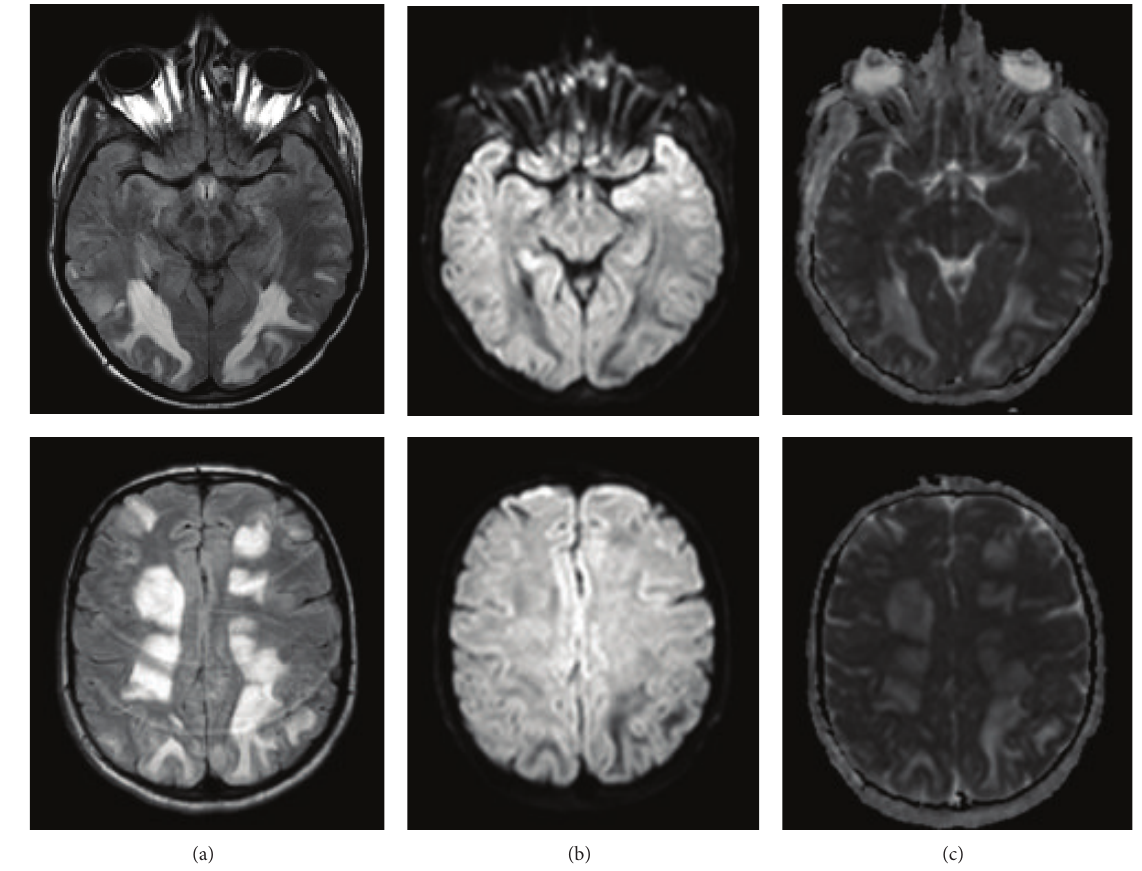
Figure 1: MRI manifestations of Patient 1. (a) Axial fluid attenuated inversion recovery (FLAIR) showed symmetrical high signal intensities in subcortical occipito-parietofrontal regions. ((b)-(c)) Diffusion-weighted magnetic resonance imaging (DWI) revealed hypointensities with high apparent diffusion coefficient (ADC), suggesting vasogenic edema.